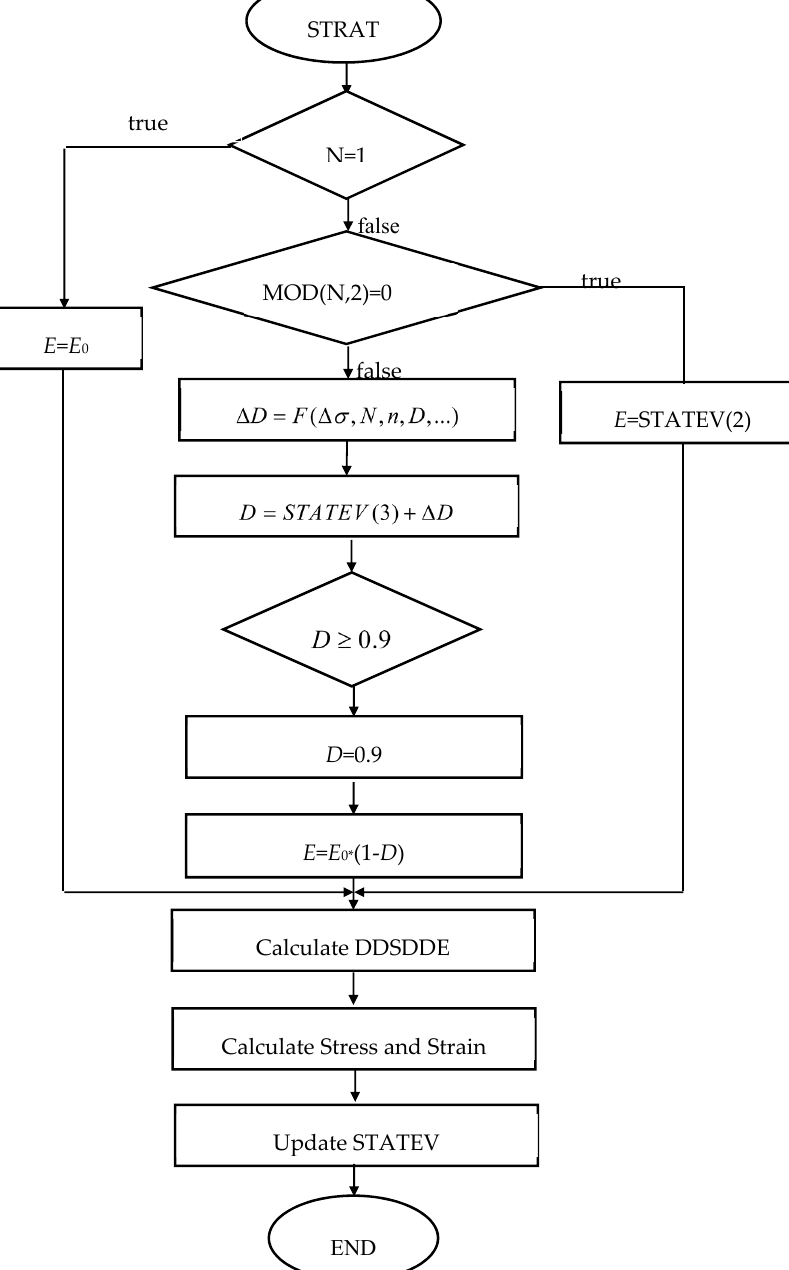
Figure 4. Flow chart of user-defined material subroutine (UMAT) algorithm.